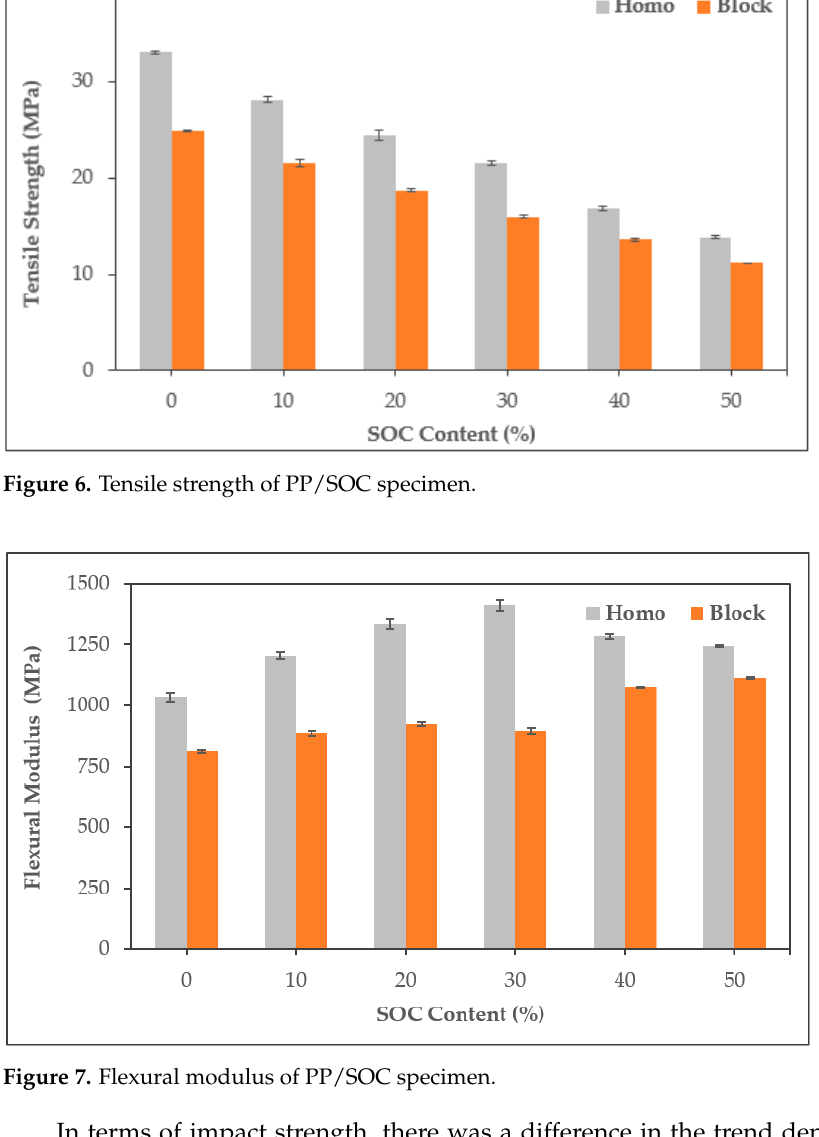
Figure 7. Flexural modulus of PP/SOC specimen.